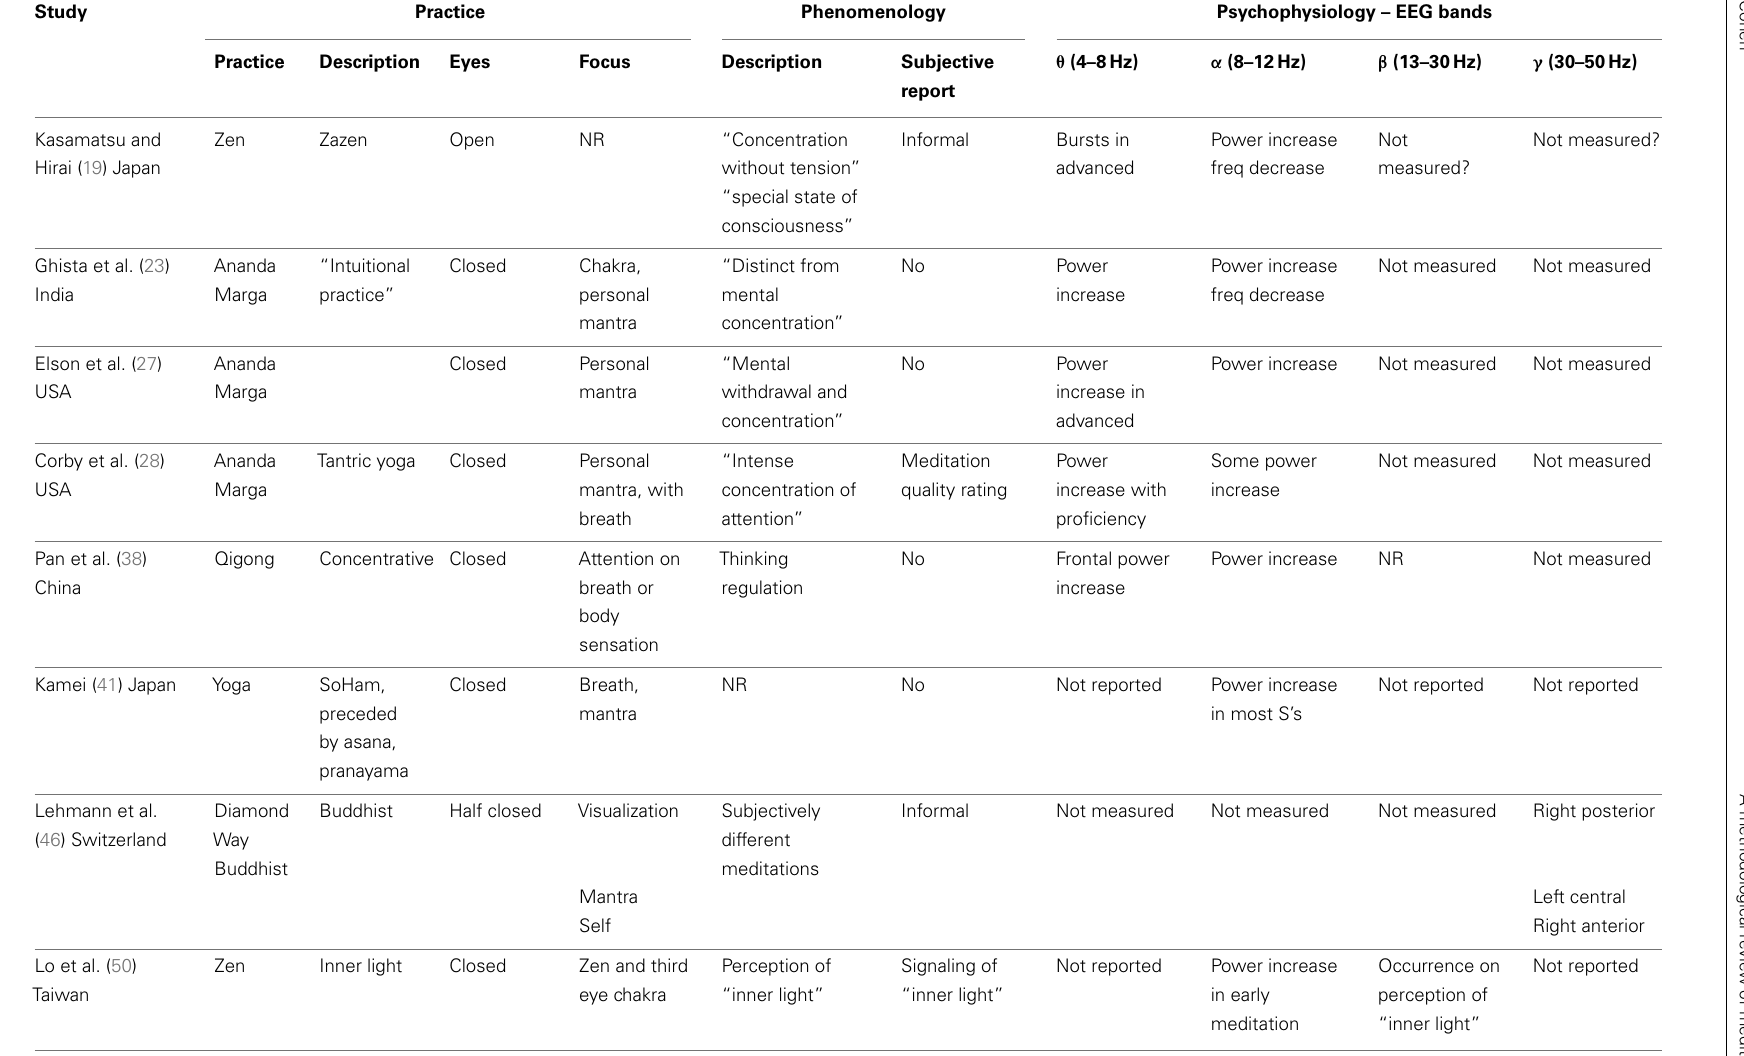
Table 2 | Studies using focused attention meditation